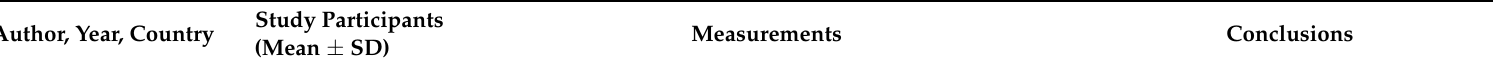
Table 1. Cross-sectional studies examining associations between vitamin D status and muscle